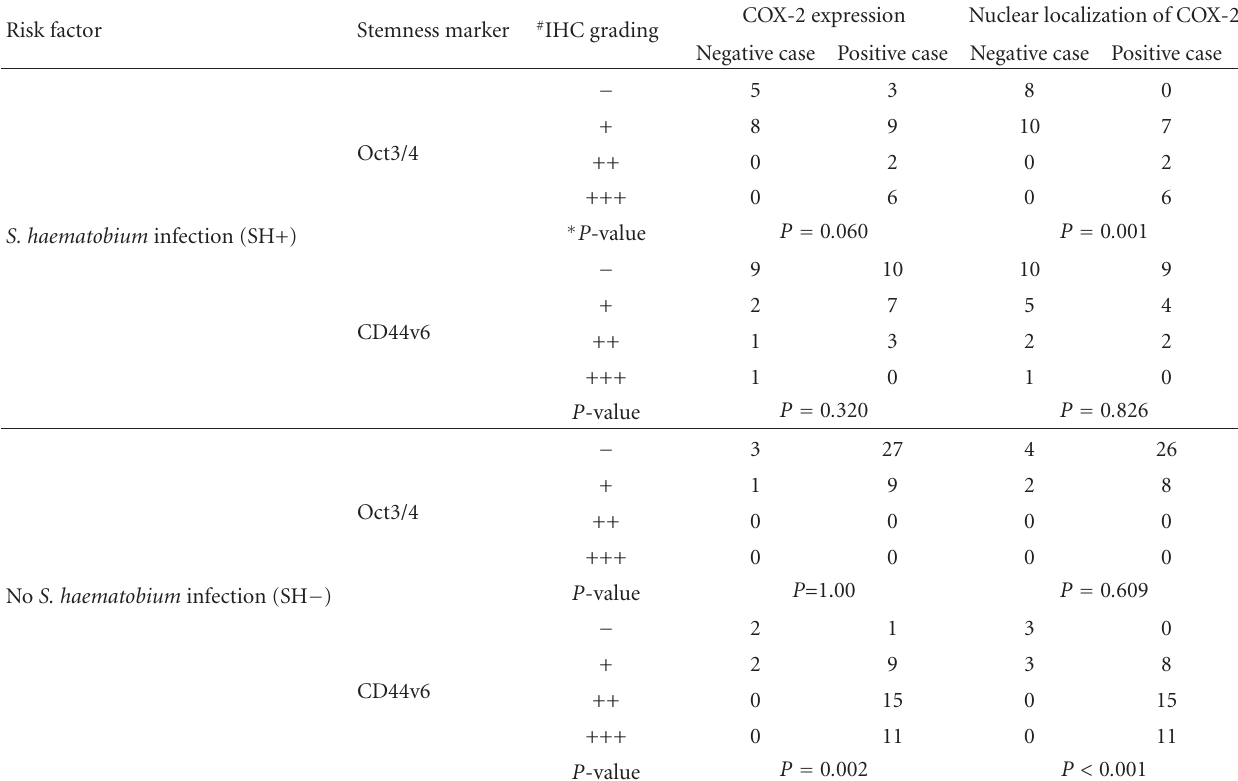
Table 3: Expression of Oct3/4 and CD44v6 in urinary bladder cancer patients positive and negative for COX-2 expression. Risk